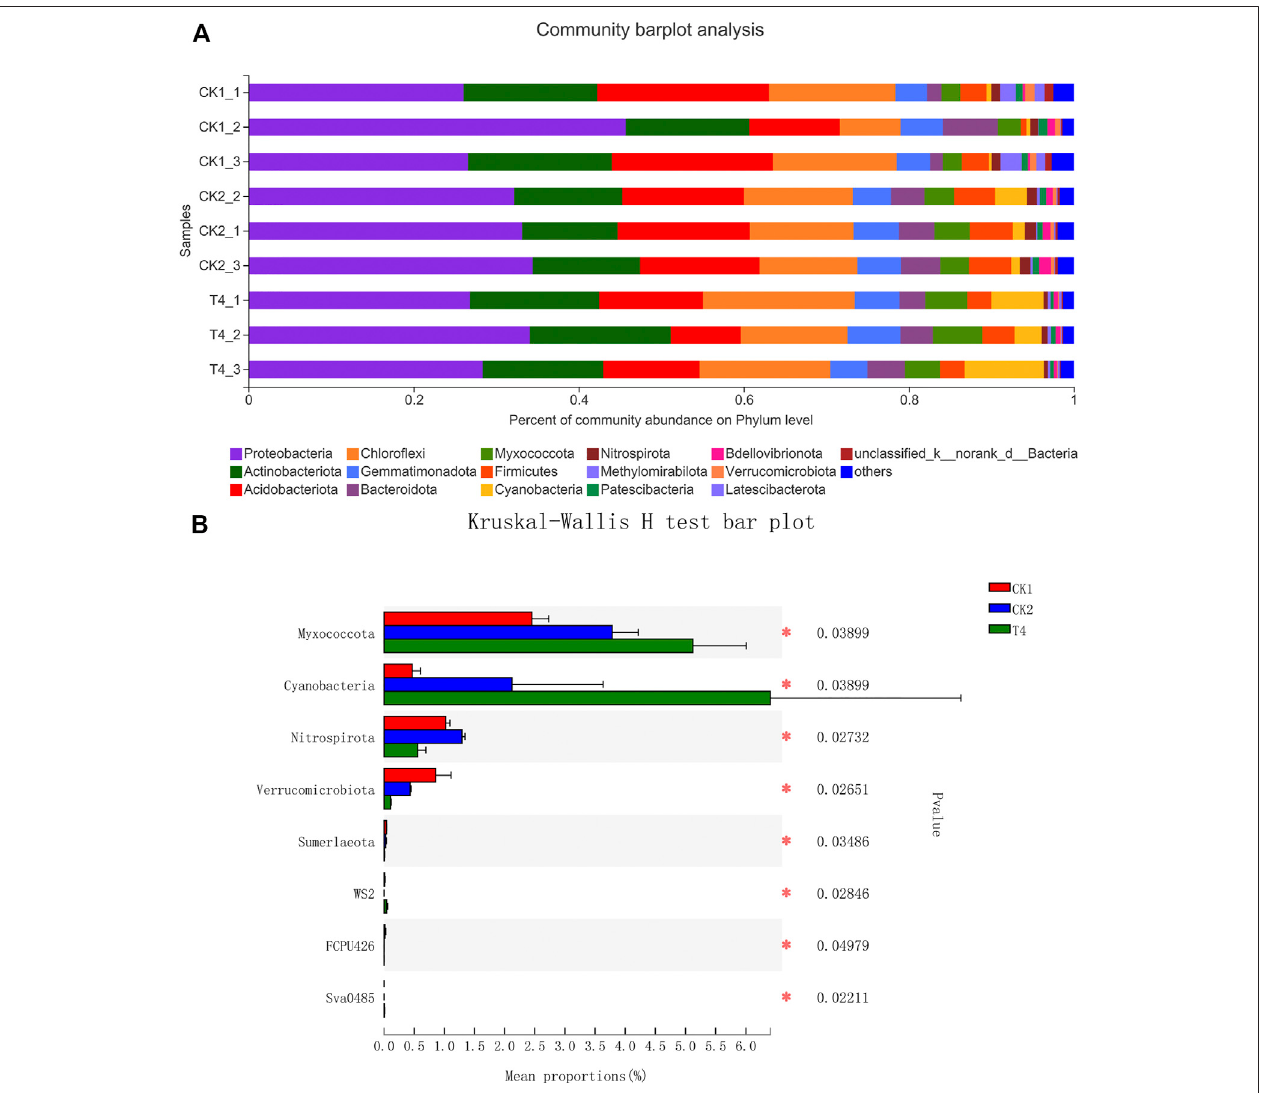
FIGURE 5 | Changes of bacteria community composition after soaking soil. (A) Percent of community abundance on Phylum level. The ordinate is the sample name, and the abscissa is the proportion of the species in the sample. The columns of different colors represent different species, and the length of the columns representstheproportionofthespecies. (B) Kruskal-WallisHtestbarplot.TheY-axisrepresentsthespeciesnameatacertaintaxonomiclevel,theX-axisrepresentsthe averagerelativeabundanceindifferentgroupsofspecies,andthecolumnswithdifferentcolorsrepresentdifferentgroups;therightmostisthe p value,*0.01 < p ≤ 0.05, ** 0.001 < p ≤ 0.01, *** p ≤ 0.001. CK1: control, CK2: high standard control, T4: soil